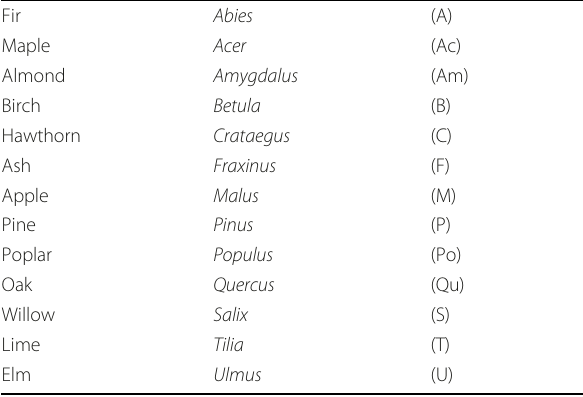
Table 1 Host trees of Viscum album , used in medical